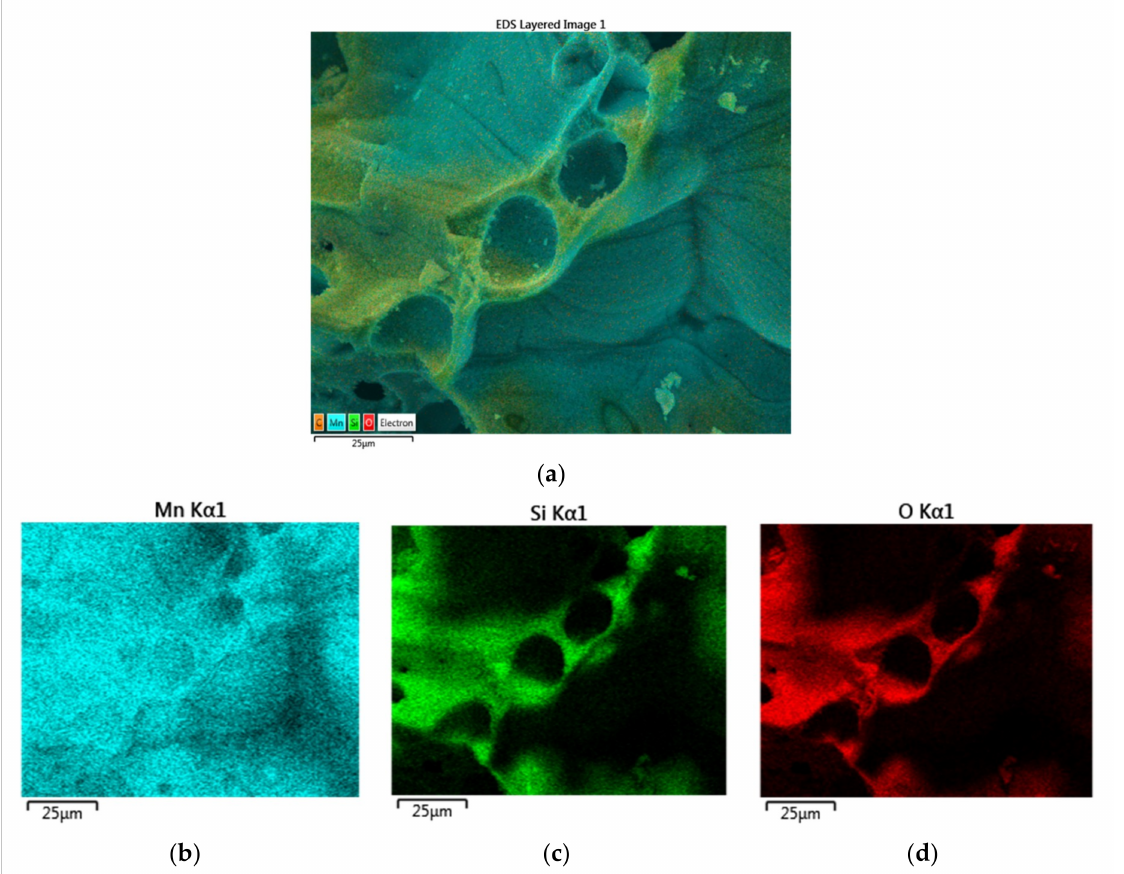
Figure 25. EDS image and mapping of Mn, Si, O of Mn / Si = 1 catalyst (Scale bar = 25 µ m). ( a ) EDS layered image; ( b ) Mn-mapping; ( c ) Si-mapping; ( d ) O-mapping. Composition at this site: [Mn] = 0.384; [Si] = 0.149; [O] =